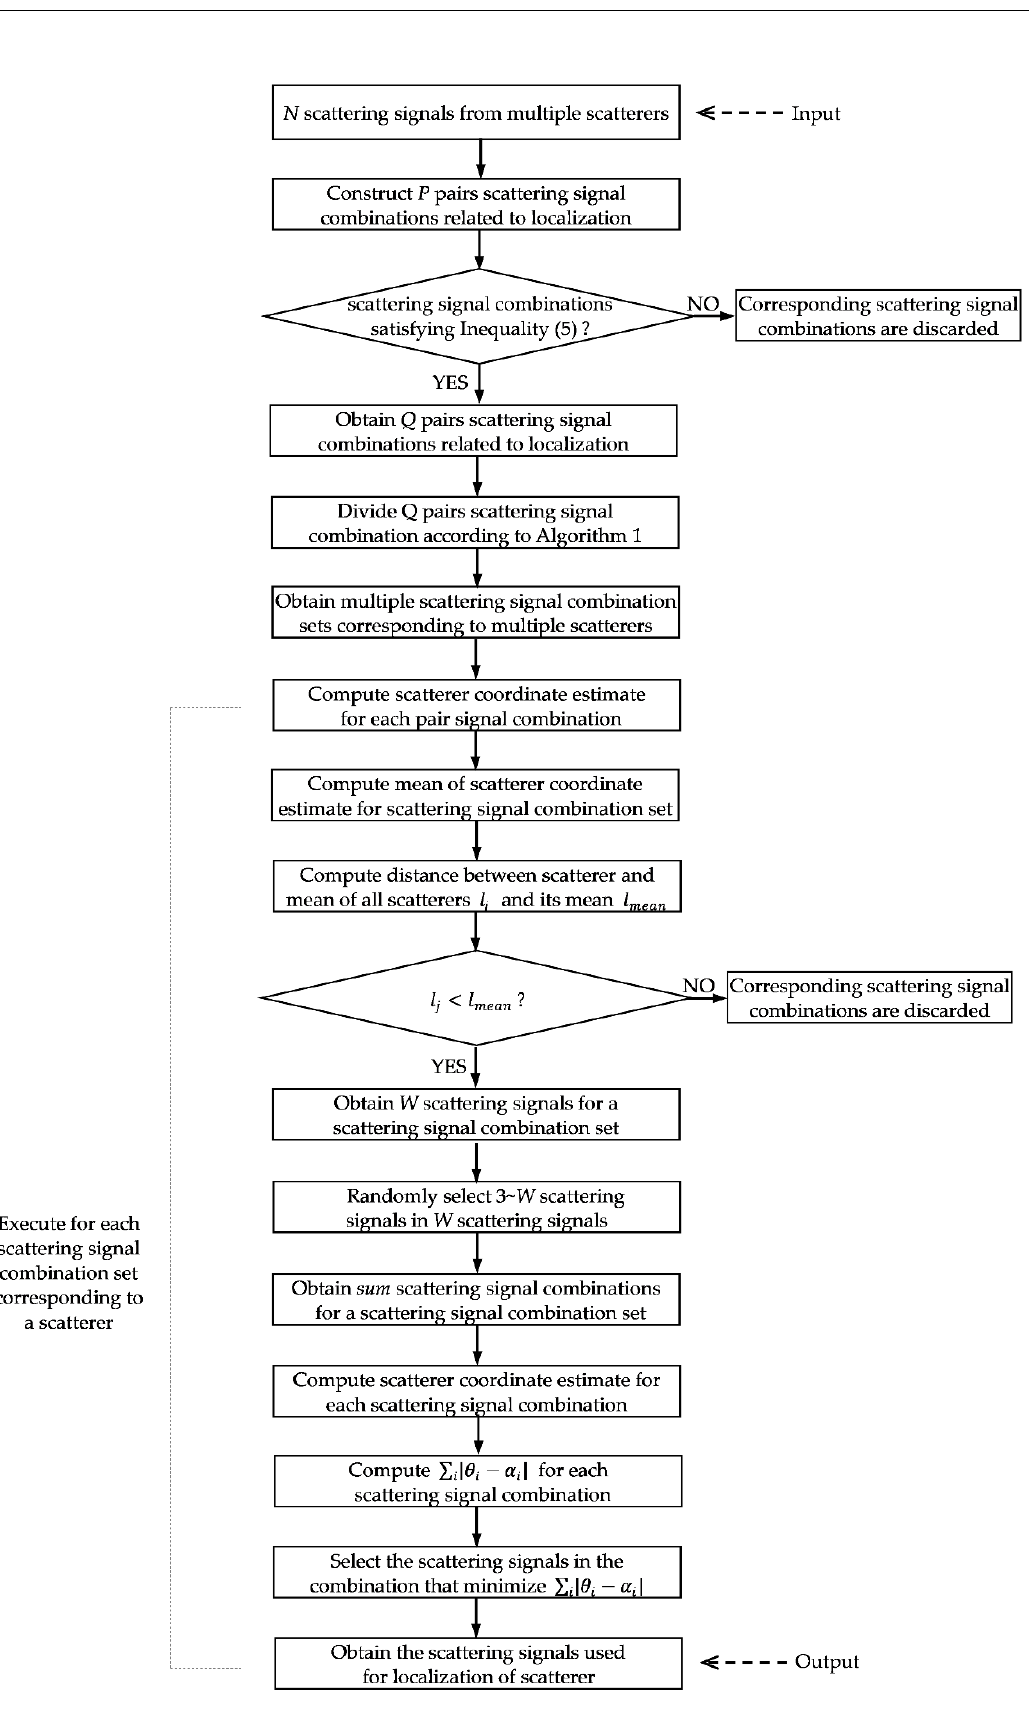
Figure 2. Flow chart of two-step one-bounce scattering signal identification algorithm used for localization of scatterer.